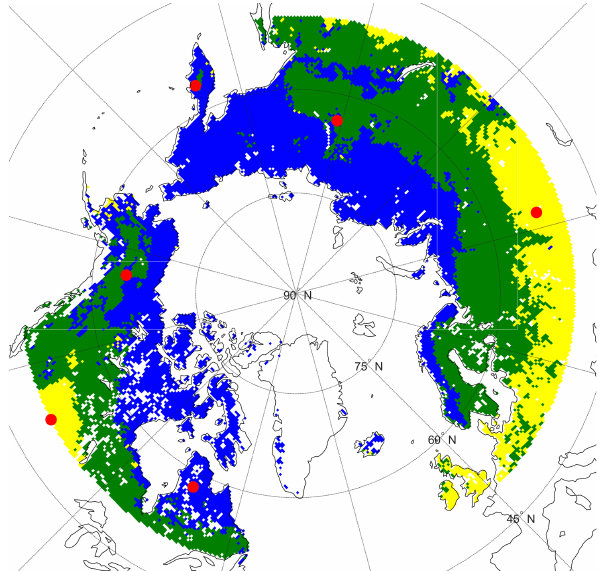
Figure 1. Land cover classes: tundra (blue), forest (green), open land (yellow) and water/ice mask (white). Red dots show weather station